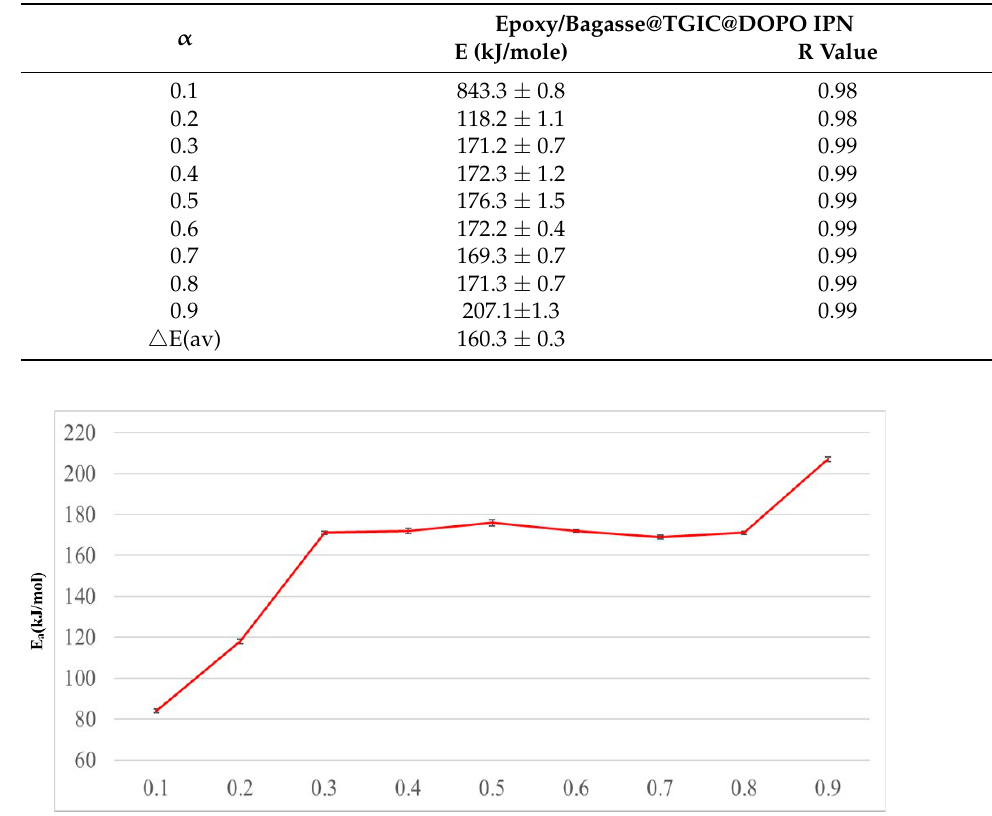
Table 1. The calculated activation energy of thermal degradation with various conversions by Ozawa’s method.